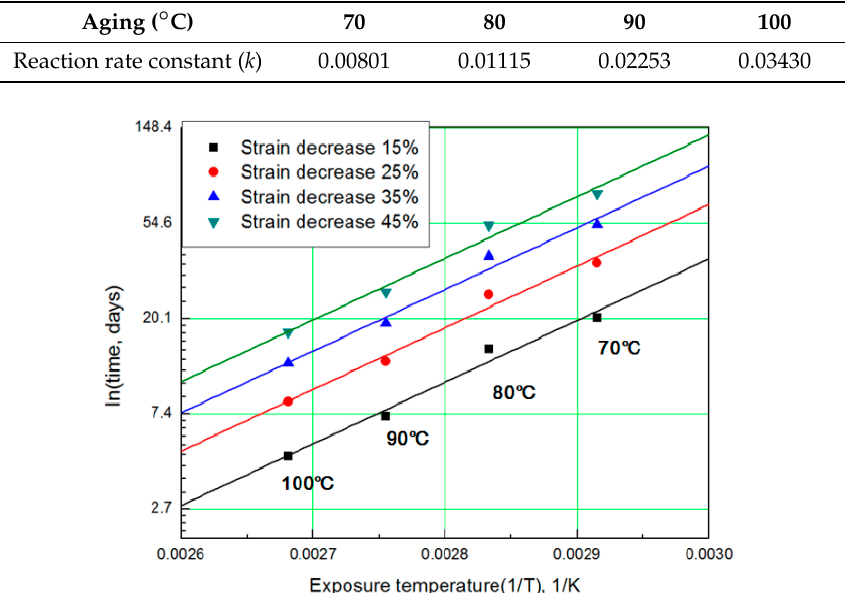
Figure 6. Characteristic equation according to aging time by temperature. Table 3. Reaction rate constant ( k ) depending on aging temperature.